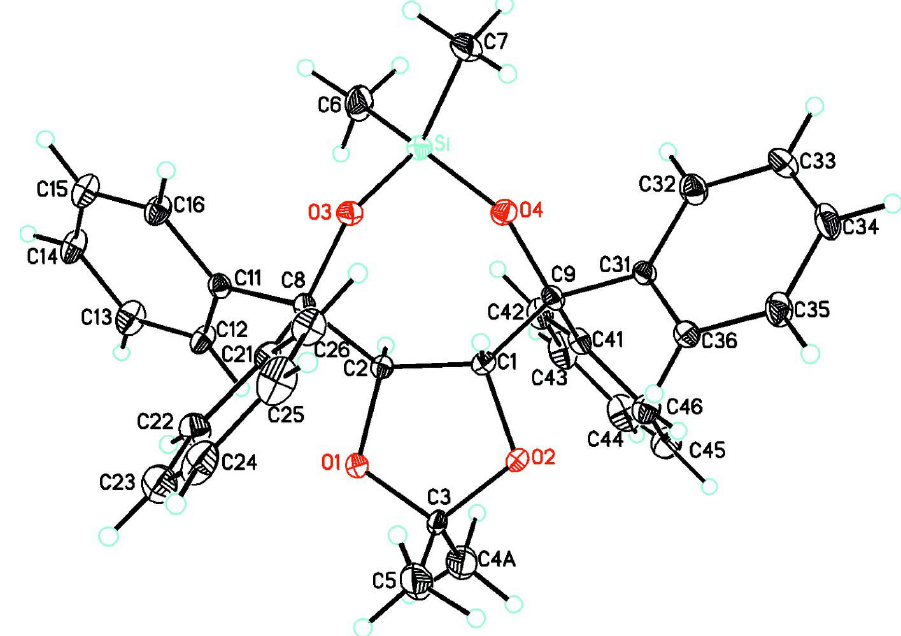
Molecular structure of the title compound, showing atom labeling and 50% probability displacement ellipsoids. Disordered aton C4A is shown with 0.38 (6) partial